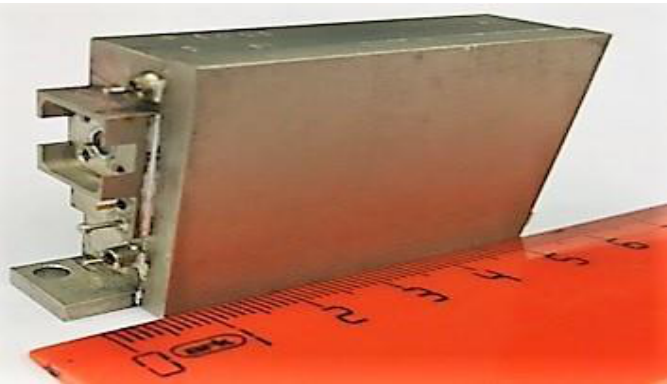
Fig. 1 . The appearance of the oscillator